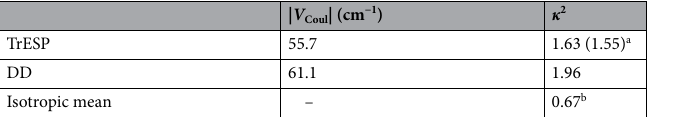
2 ) obtained with 2 is included for comparison. a Value in